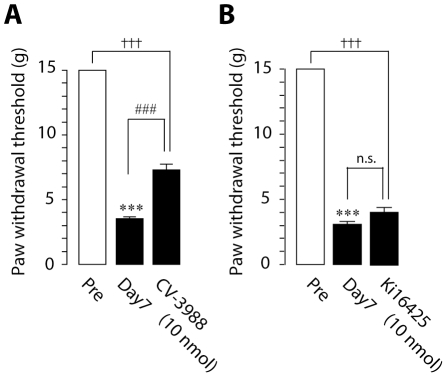
Inhibition of PAFR induces a relieving effect on existing tactile allodynia.A. The decrease in paw withdrawal threshold was attenuated by a single administration of CV-3988 (10 nmol/10 µl) (A), but not Ki16425 (10 nmol/10 µl) (B), through a catheter whose tip was positioned near the L5 DRG on day 7 after nerve injury. ***p<0.001, †††p<0.001 compared with pre-injury baseline (Pre). ###p<0.001 compared with the threshold on day 7. n.s. means “not significant”. All data are presented as mean ± SEM of the paw withdrawal threshold of five to eight animals.